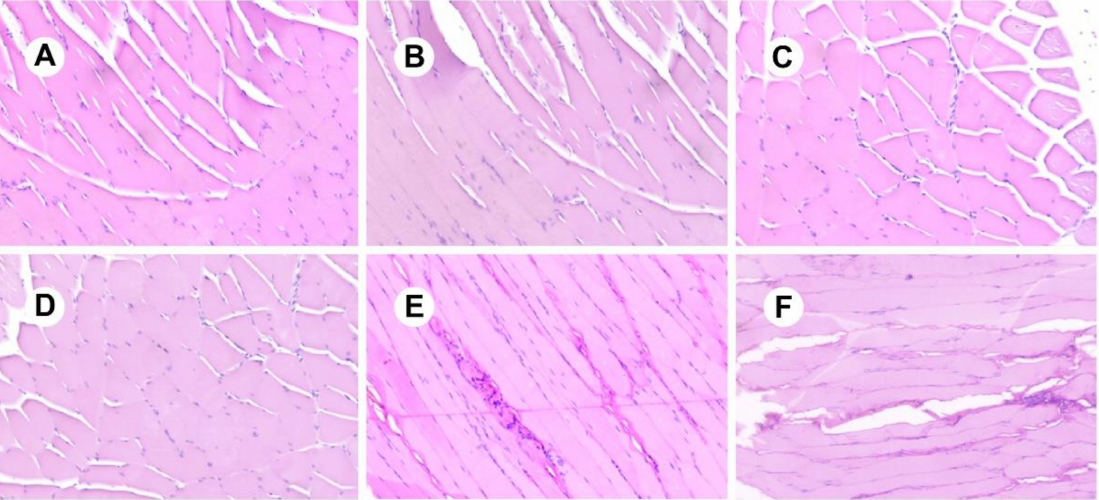
Figure 8. Tissue sections of the implants. ( A ) 0 days; ( B ) 15 days; ( C ) 30 days; ( D ) 60 days; ( E ) 90 days; ( F ) 120